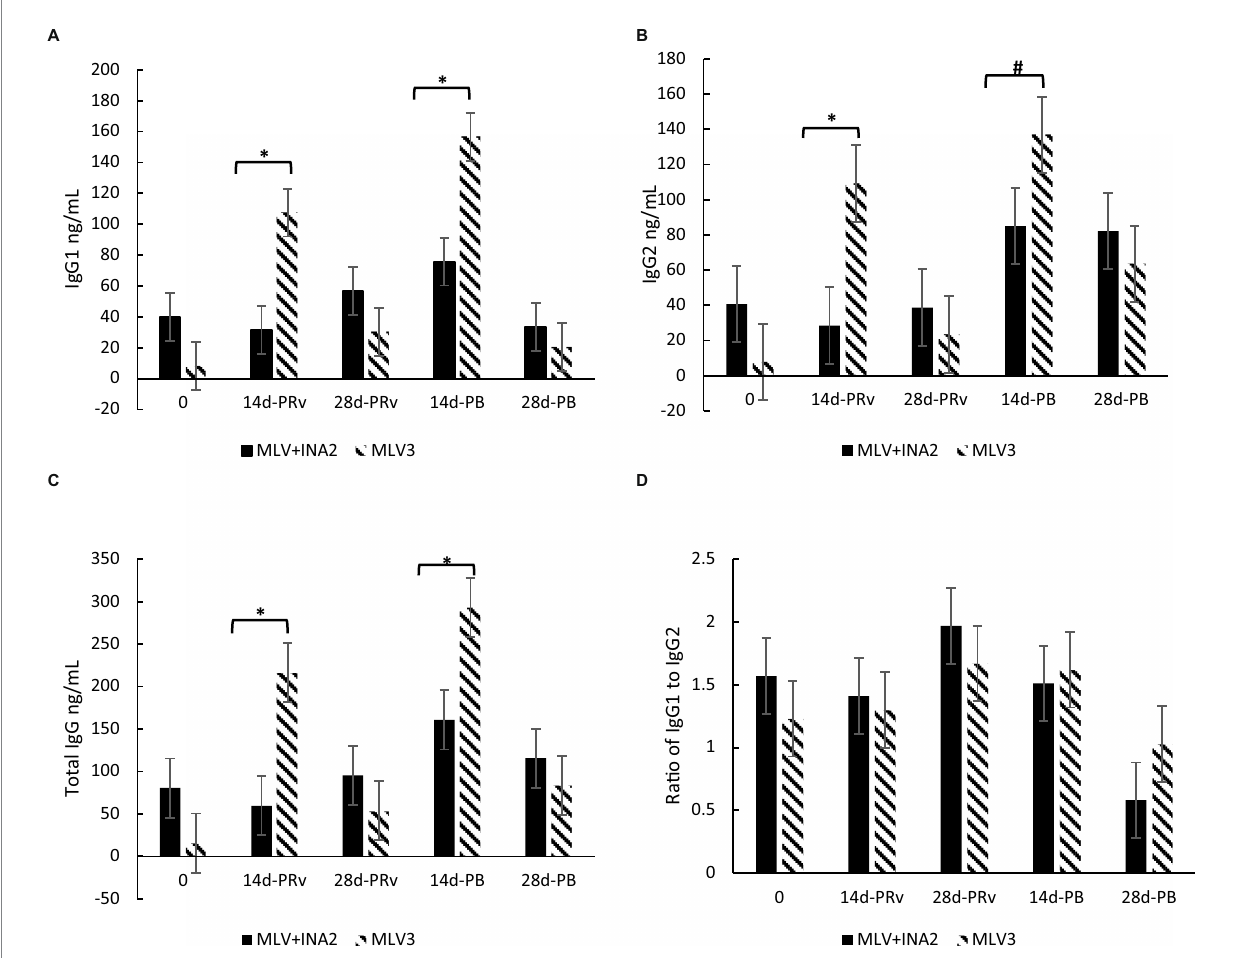
FIGURE 3 Effect of vaccine treatment by day on serum concentrations (ng/mL) of immunoglobulin G1 (A) , immunoglobulins G2 (B) , and total immunoglobulin G (C) and the ratio of Immunoglobulin G1:Immunoglobulin G2 ratio (D) at 14 and 28 days post-revaccination (PRv) and post-booster (PB), n = 28 heifers. Data are expressed as means ± standard error of the mean. Means with * between treatments within a day differ at p < 0.05 and means with # differ at p < 0.10. Treatment × Day = p < 0.0001 for IgG1, p < 0.05 for IgG2, p = 0.002 for Total IgG, and p > 0.65 for the Ratio of IgG1 to IgG2.